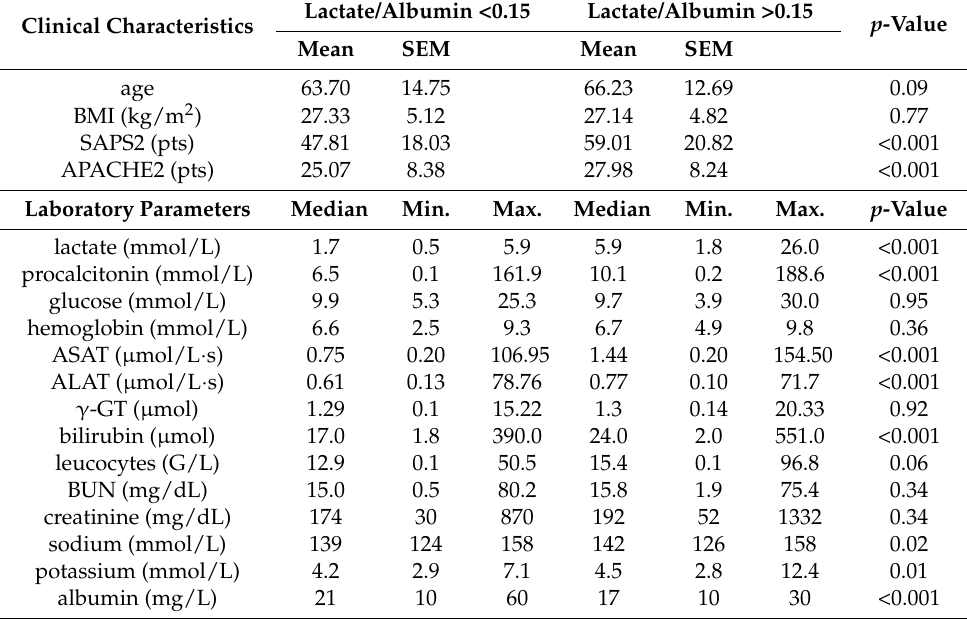
Table 2. Laboratory and clinical baseline characteristics; lactate/albumin >0.15 vs. lactate/albumin <0.15. Clinical